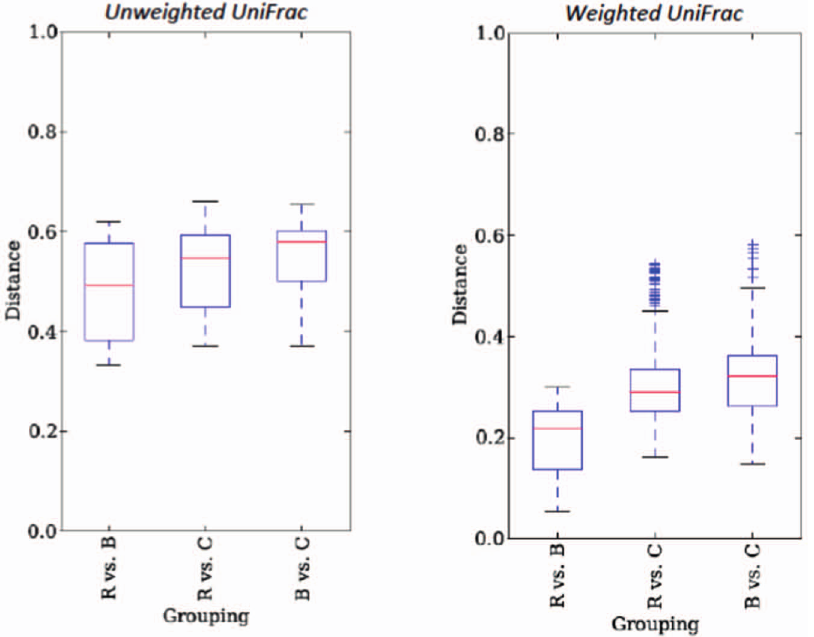
Figure 5. Box plots of beta-diversity distances between communities for both weighted and unweighted analyses. Initials (i.e. B vs. C) stand for comparisons of beta-distances for samples within groups (R= rhizosphere, C= Cannabis endorhiza, B= bulk